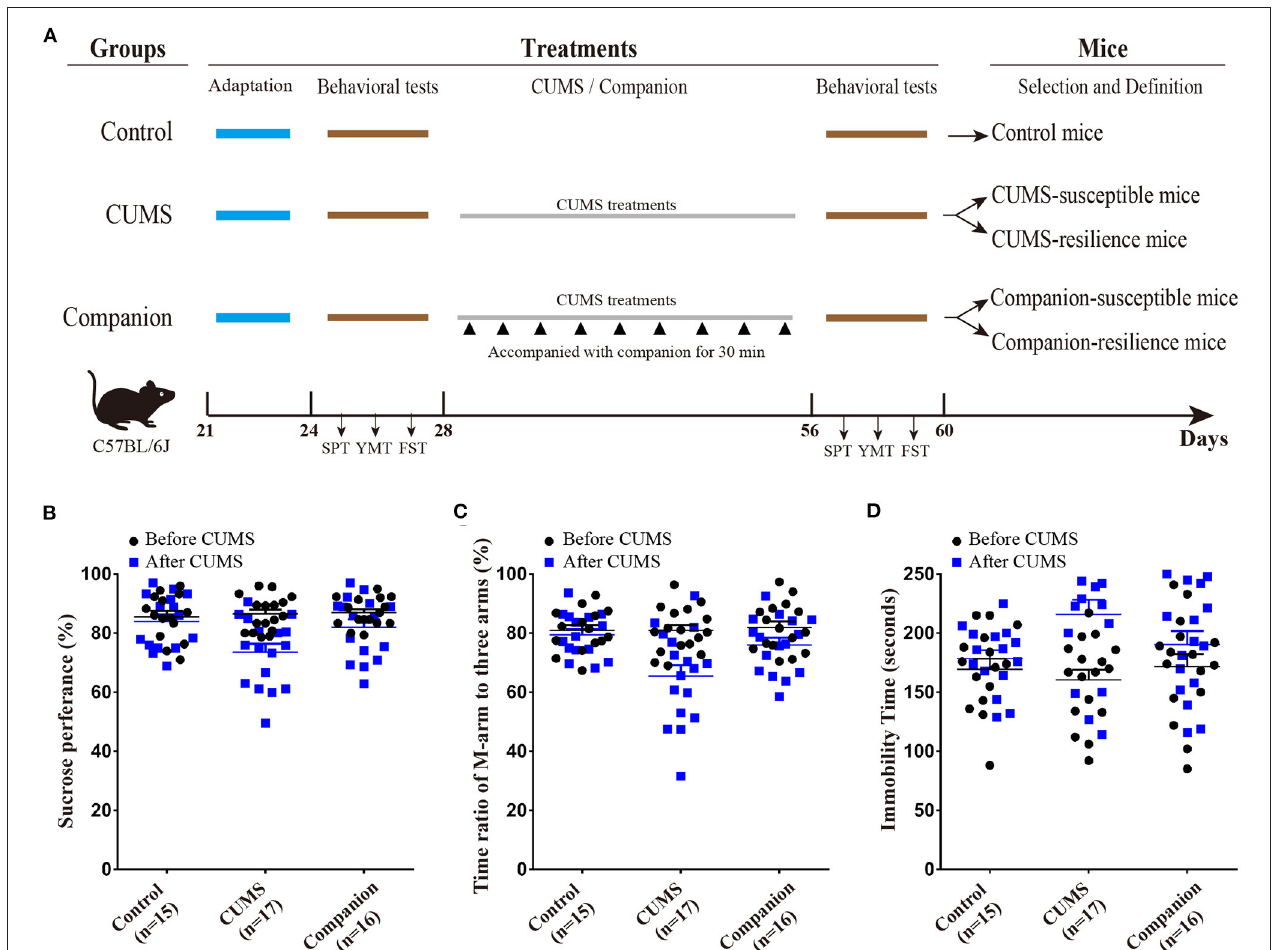
FIGURE 1 | CUMS-induced depression-like behaviors were ameliorated by accompanying with companion. (A) Procedure for generating CUMS-susceptible, CUMS-resilience, Companion-susceptible, and Companion-resilience mice, including adaptation, behavioral tests, CUMS, CUMS with companion treatments, and definition. (B) Sucrose preference test values (%) before (Black) and after (blue) treatments in Control ( n = 15), CUMS ( n = 17), and Companion groups ( n = 16). (C) Time ratios of M-arm to three arms before (Black) and after (blue) treatments in Control ( n = 15), CUMS ( n = 17), and Companion groups ( n = 16). (D) Immobile time of staying in the water cylinder before (Black) and after (blue) treatments in Control ( n = 15), CUMS ( n = 17), and Companion groups ( n = 16). Two-way ANOVA was used for the comparisons among control, CUMS, and Companion groups.